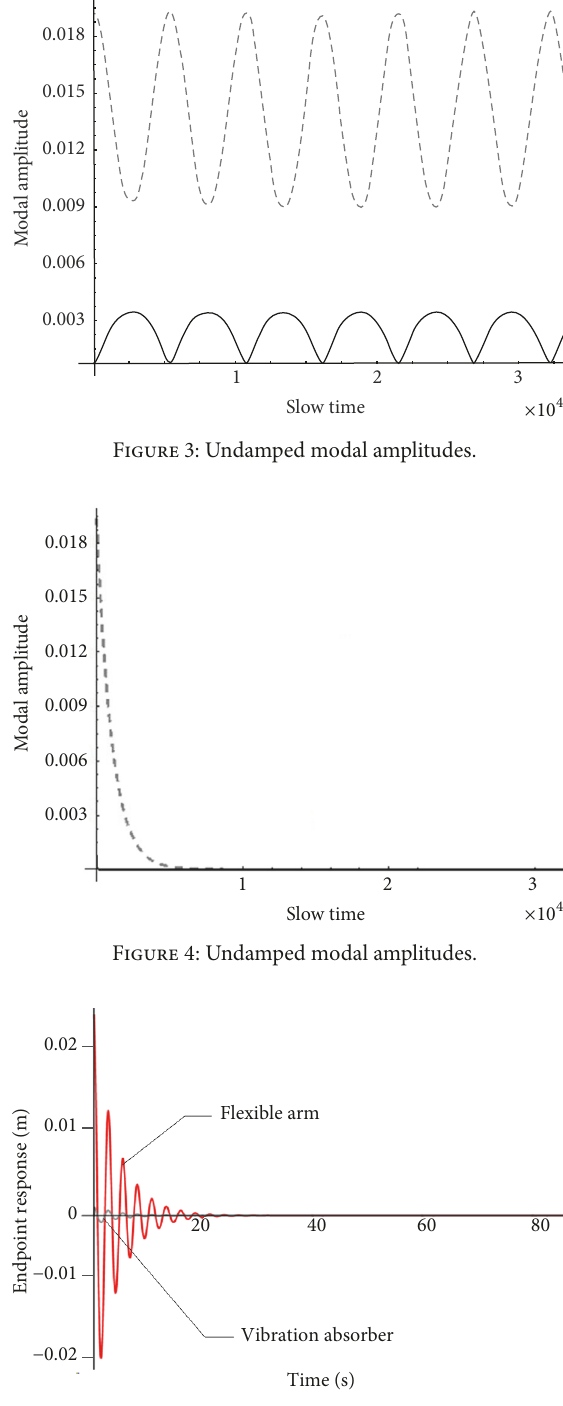
Figure 5: Endpoint response of the flexible